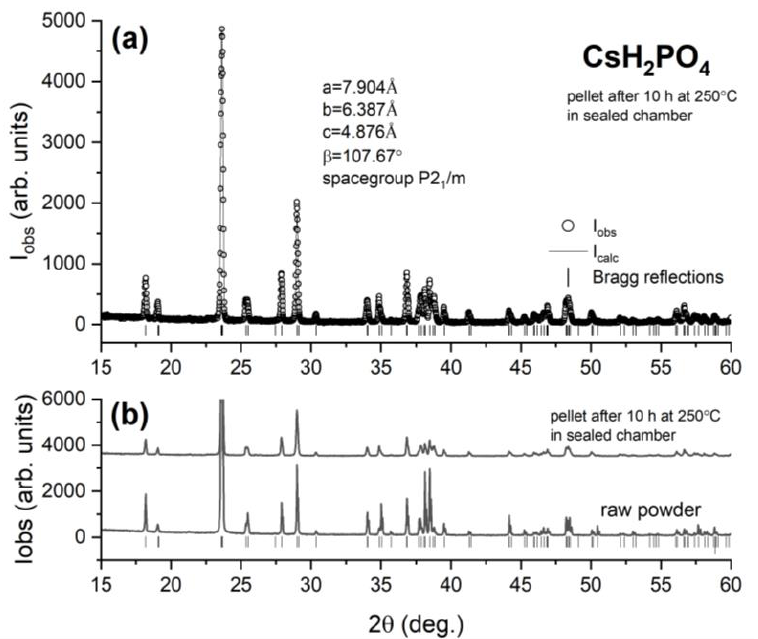
Figure 5. ( a ) Le Bail (full profile) fit to X-ray diffraction data from a CDP pellet after being used in the 50 mL sealed chamber experiment for 10 h at T = 250 °C. The empty symbols show the observed intensity as a function of the detector angle 2θ and the solid line is the fit. The vertical bars mark the positions of the Bragg reflections from CDP’s room temperature. ( b ) Comparison between the X-ray diffraction pattern from the as prepared powder and that from its counterpart collected on the pellet kept for 10 h at T = 250 °C in the 50 mL chamber.